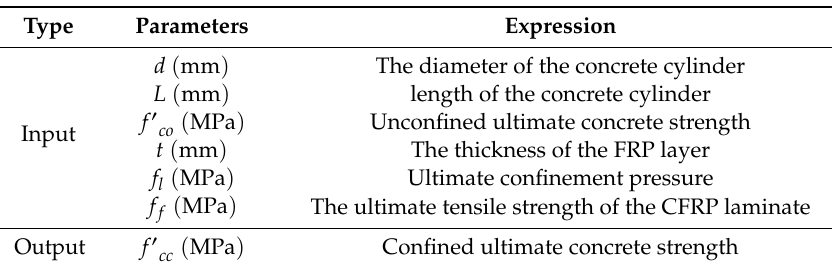
Table 2. Input and output